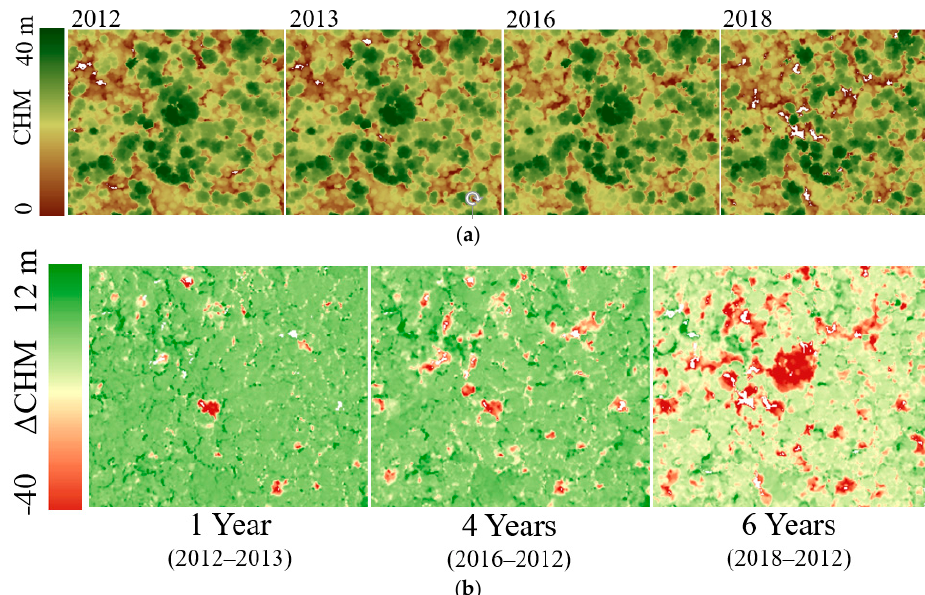
Figure 4. Example of forest dynamics showing temporal changes in LiDAR CHM for a small area (6.1 ha) within the limits of the HMTF. The CHM image for all the years is presented in ( a ). The forest dynamics, described by changes in CHM using 2012 as a base year, is shown in ( b ). Notable differences are expressed in (b), especially for the apparent loss of large canopies between 2012 and 2018.